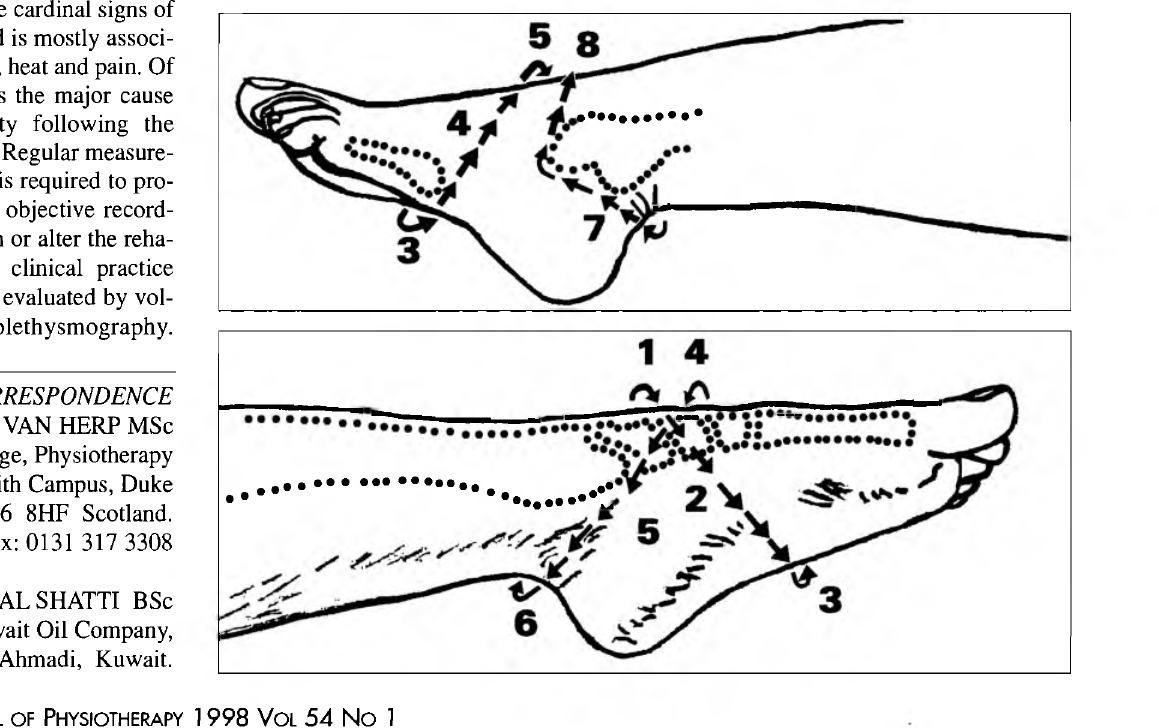
Figure 1: The figure-of-eight method of ankle